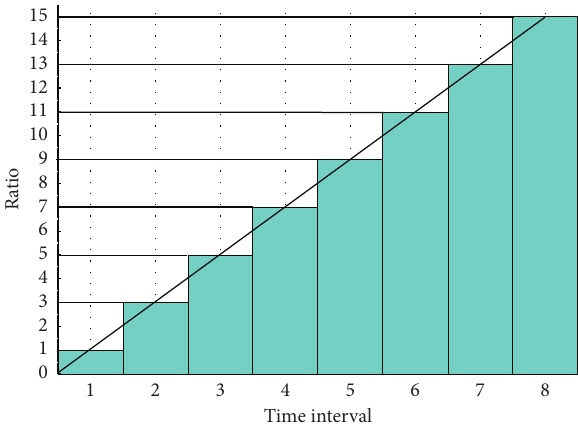
Figure 4: Distribution of linearly increasing hyetograph. Table 5: Distribution of linearly increasing hyetograph.